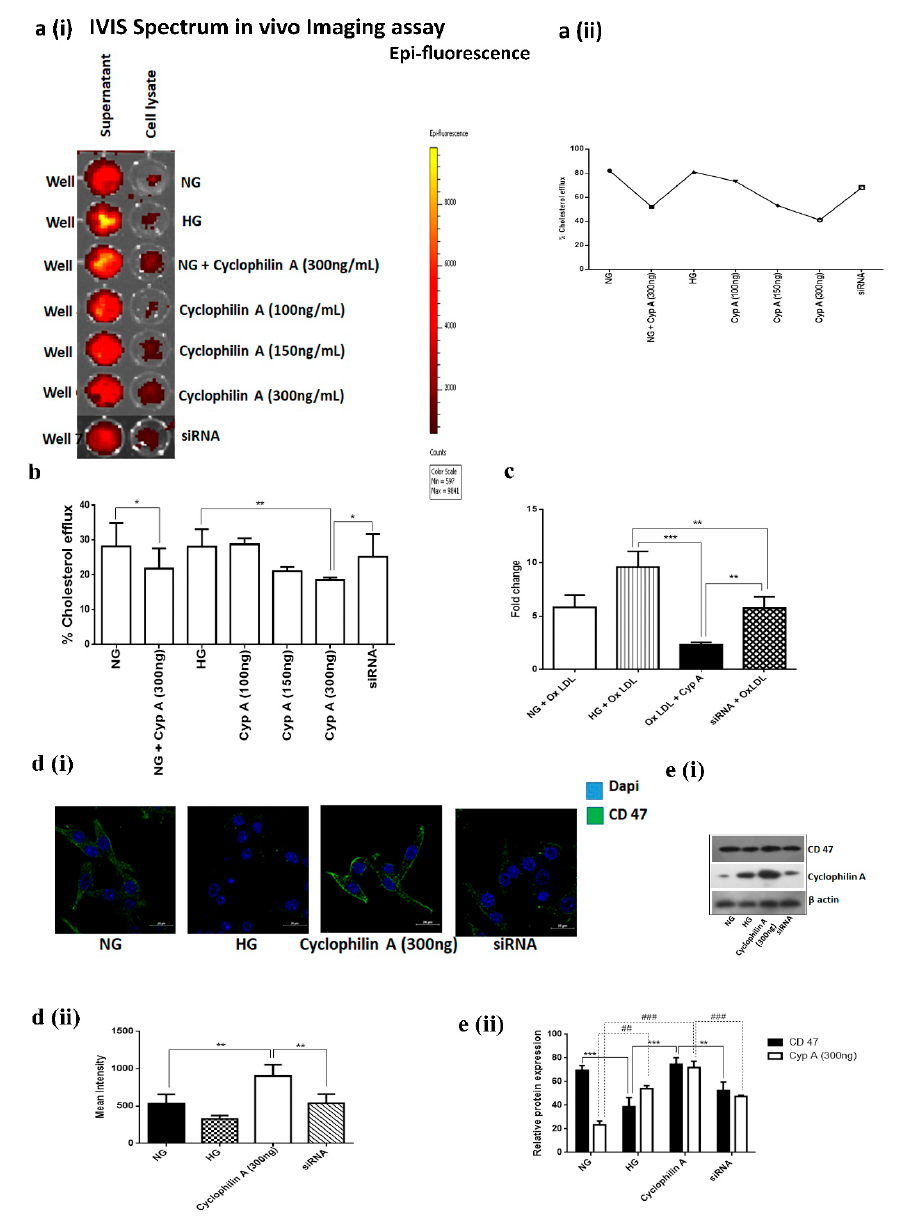
Figure 2. Cyclophilin A reduces cholesterol efflux of macrophages. Cholesterol efflux was measured in an in vitro system using a cell-based cholesterol efflux assay kit after exposing macrophage cells preloaded with labelled cholesterol in the presence of Cyp A to a cholesterol acceptor, such as HDL or human serum. ( a ) (i and ii). Percentage cholesterol efflux was evaluated by in vivo IVIS Spectrum Imaging assay; ( b ) cholesterol efflux in cells was measured using a cell-based cholesterol efflux assay kit. Efflux from Cyp A-treated macrophages was reduced in 5 h (41%), compared to control cells (82%); ( c ) gene-expression analysis of ABCA1 mRNA by RT-PCR. ( d ) (i and ii). Confocal images indicate increased cellular-level expression of CD 47 in Cyp A-treated macrophages, similar to untreated macrophages; * p < 0.05 was considered significant. ( e ) (i and ii). The expression of CD 47 and in Cyp A macrophages treated by immunoblotting. * p < 0.05, ** p < 0.01, *** p < 0.001 for CD 47 and # p < 0.05, ## p < 0.01 ### p < 0.001 for Cyp A was considered significant. The data were compared using a one-way ANOVA, followed by multiple-comparison test using an SNK